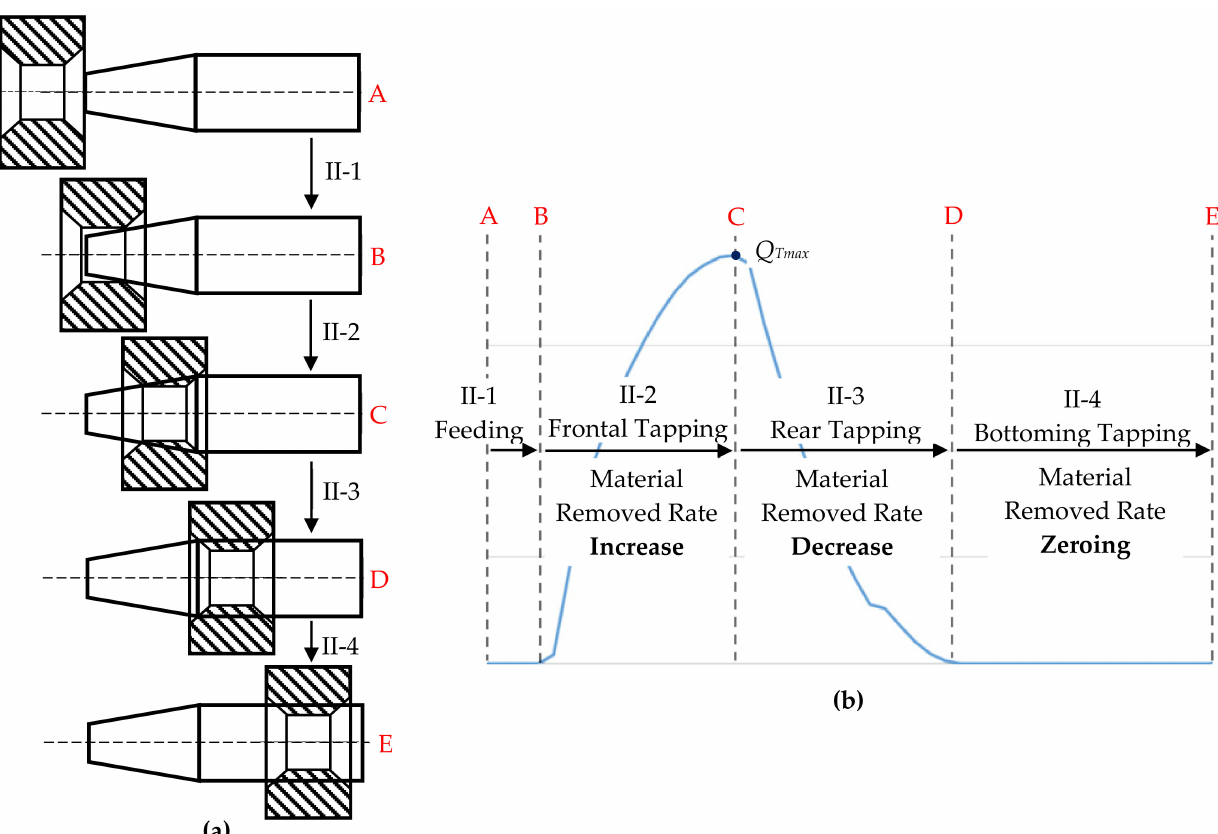
Figure 4. The material removal rate for tapping process II: ( a ) the relative movement of a nut and its tap; ( b ) four stages in tapping process